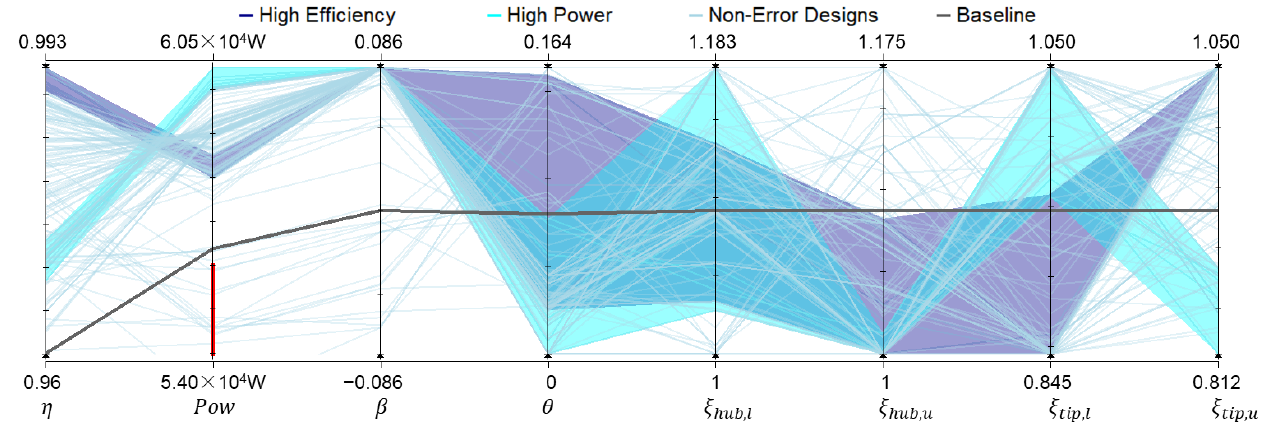
Figure 8. Parallel plot highlighting selected design parameters of different groups of designs.